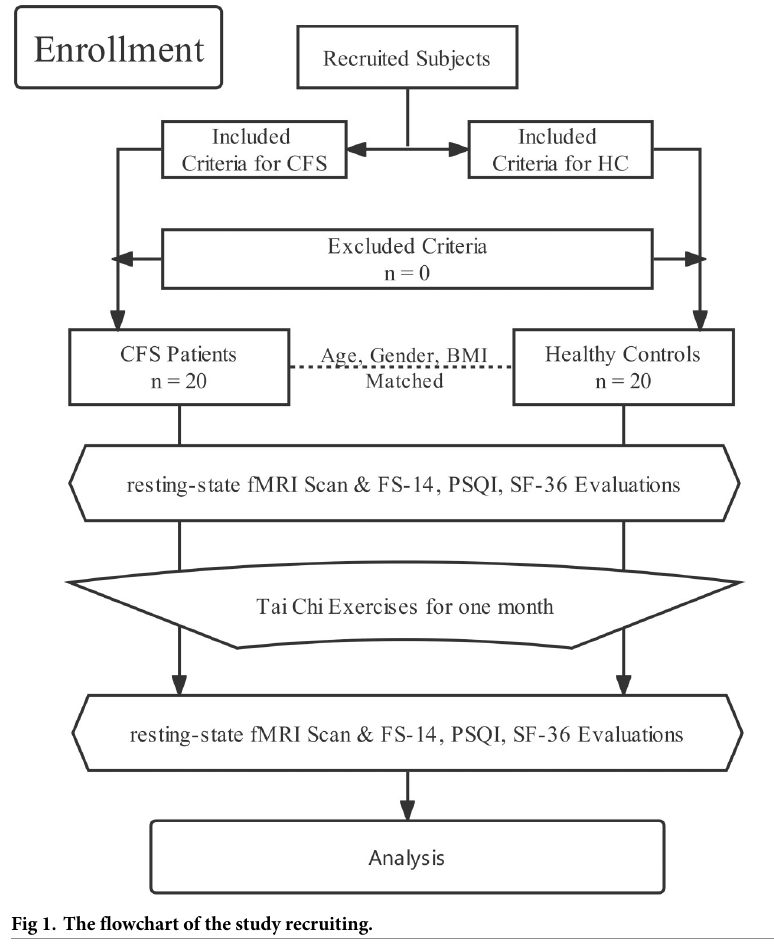
Fig 1. The flowchart of the study